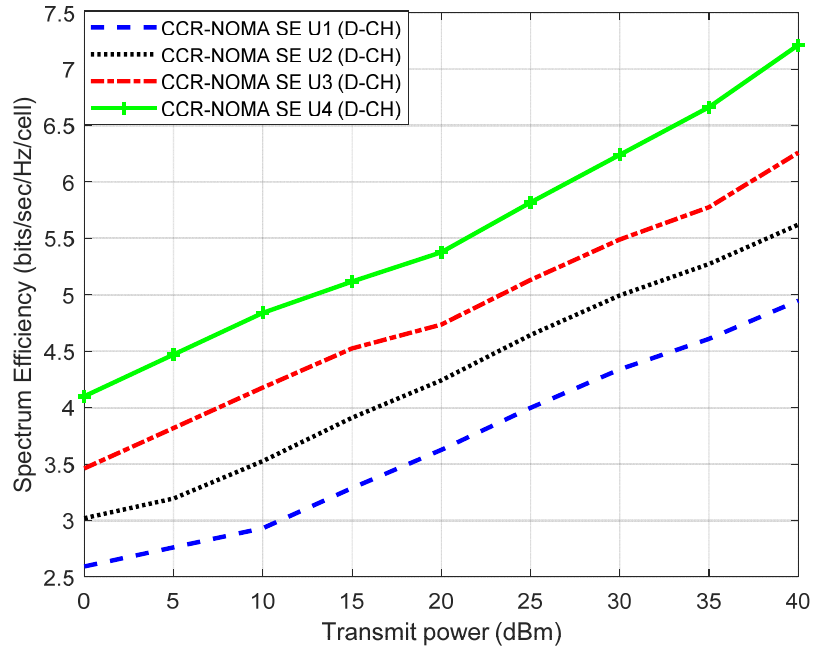
Figure 6. SE versus transmitting power for 4 users’ SISO DL NOMA PD with D-CH CCRN.